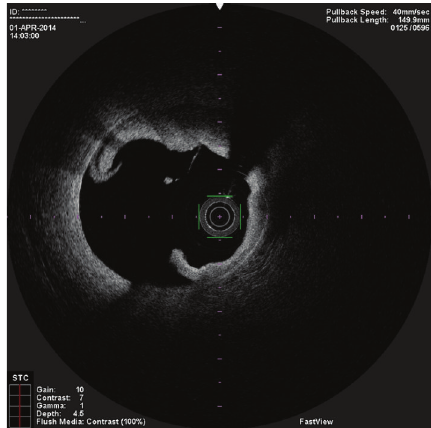
Figure 6: OCT image showing the guidewire in the true lumen and the false lumen with signs of thrombosis in